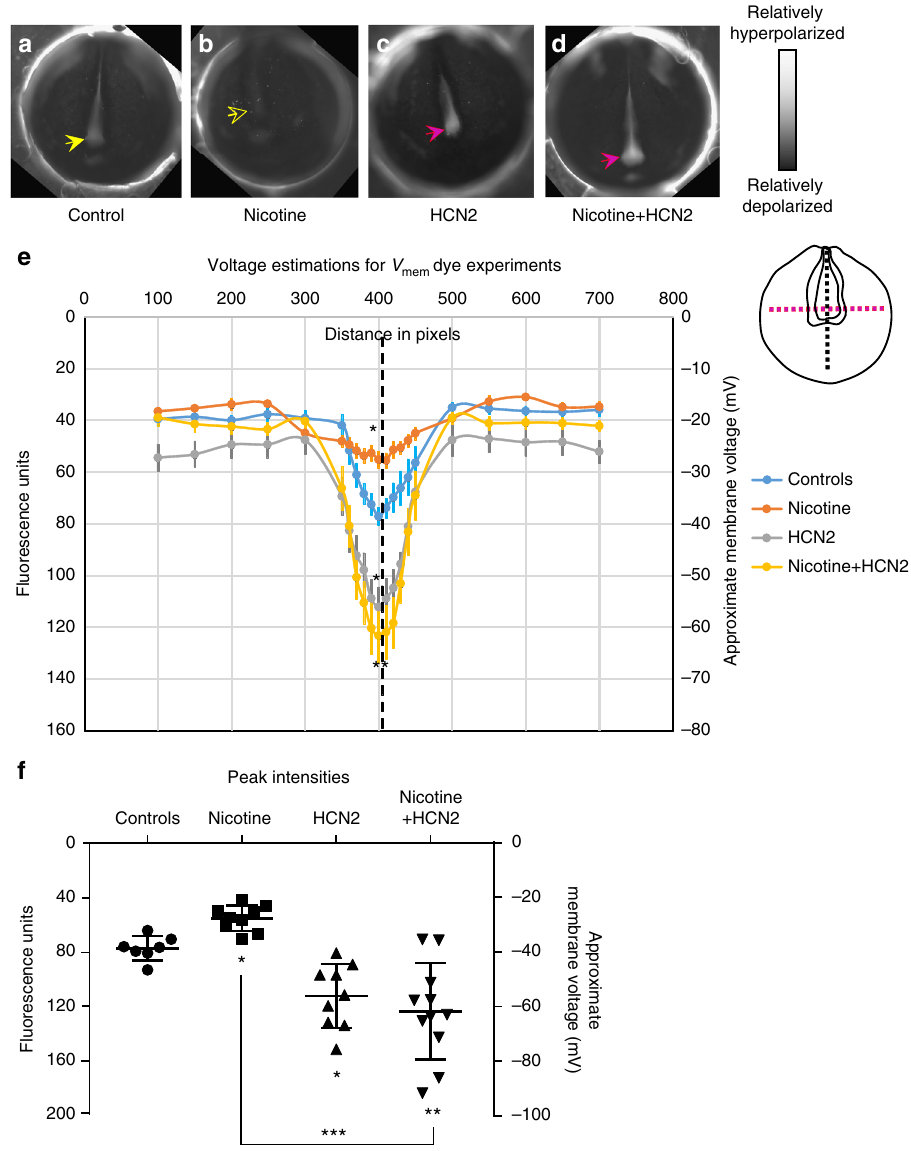
Fig. 4 Validation of the model prediction of nicotine effects and HCN2-induced recovery of membrane voltage prepatterns. Representative CC2-DMPE: DiBAC 4 (3) images of stage ~15 Xenopus embryos: a untreated controls, b nicotine-exposed (0.1 mg/mL – stage 10 – 35), c Hcn2-WT mRNA microinjected (0.75 ng/injection) in both blastomeres at 2-cell stage, and d nicotine-exposed (0.1 mg/mL – stage 10 – 35) and Hcn2-WT mRNA microinjected (0.75 ng/ injection) in both blastomeres at 2-cell stage. Control embryos show the characteristic hyperpolarization (solid yellow arrow) as previously reported 28 . Nicotine-treated embryos show reduced signal (depolarized) within the neural tube (hollow yellow arrow). Hcn2-WT mRNA microinjection show enhanced signal (hyperpolarized) within the neural tube (magenta arrows), in presence or absence of nicotine exposure. e Quanti fi cation of CC2-DMPE:DiBAC 4 (3) images of stage ~15 Xenopus embryos along the red dotted line as indicated in the inset illustration, along with electrophysiology based membrane voltage approximations (as previously reported in refs. 27,28 ). The fl uorescence intensity/membrane voltage pattern within the neural tube (indicated by the black dotted line in the inset illustration and corresponding lack dotted line in the graph) is signi fi cantly reduced (depolarization) in nicotine-exposed embryos in comparison to controls. Hcn2-WT mRNA microinjection signi fi cantly enhances the fl uorescence intensity/membrane voltage patterns within the neural tube in comparison to controls. Nicotine-exposed embryos that are microinjected with Hcn2-WT mRNA maintain a signi fi cantly enhanced fl uorescence intensity/membrane voltage pattern within the neural tube in comparison to only nicotine-treated embryos. N = 10 embryos for each treatment group at each of the indicated spatial distance in pixels were collected from multiple animals across independent clutches. Data is plotted as mean ± S.E.M. Data at black line (400 Pixels) was analyzed using one way ANOVA, * p < 0.05, ** p < 0.01. ( f ) Quanti fi cation of peak fl uorescence intensity and electrophysiology based membrane voltage approximations (as previously reported in ref. 27,28 ) from voltage reporter dye images (CC2-DMPE:DiBAC 4 (3)) of ~stage 15 Xenopus embryos within the neural tube at the intersection of the red and black dotted lines in the inset illustration in ( a ). Nicotine exposure signi fi cantly reduced (depolarizes) the neural tube peak intensity/membrane voltage in comparison to controls. Hcn2-WT mRNA microinjection, both in presence or absence of nicotine, signi fi cantly enhances (hyperpolarizes) the neural tube peak intensity/membrane voltage in comparison to controls. N = 10 embryos for each treatment group at each of the indicated spatial distance in pixels were collected from multiple animals across independent clutches. Data is plotted as mean ± SD and was analyzed using one way ANOVA, * p < 0.05, ** p < 0.01, *** p <